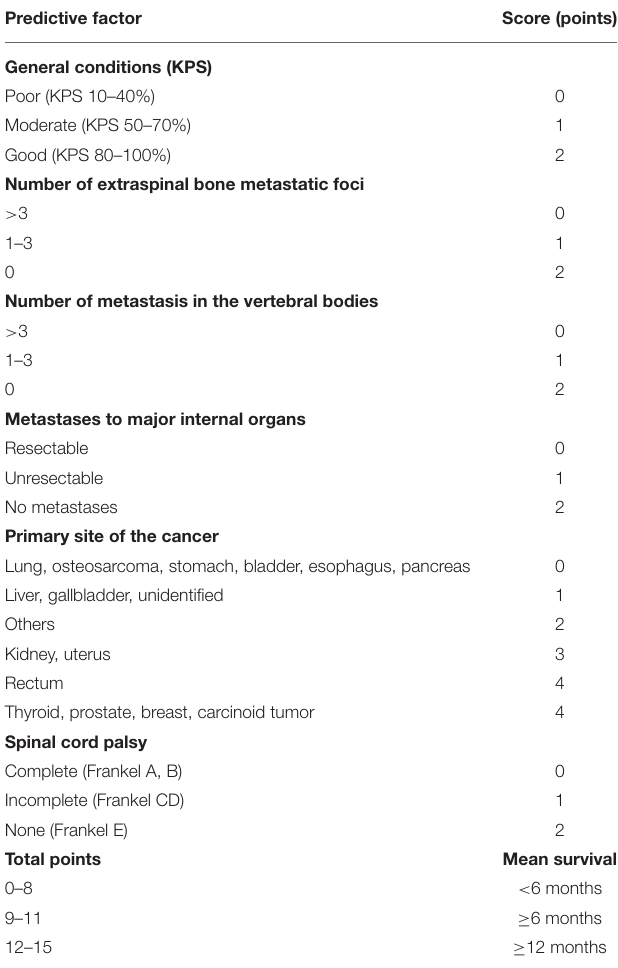
TABLE 1 | Revised Tokuashi